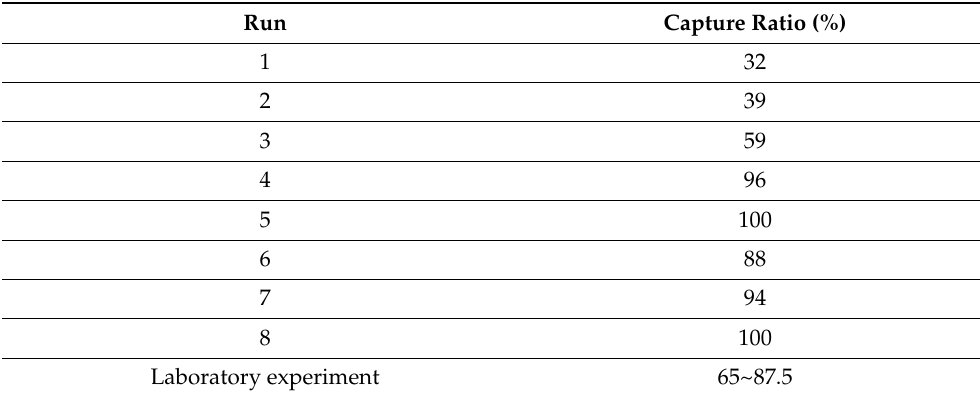
Table 3. Driftwood capture ratios in each run and in the